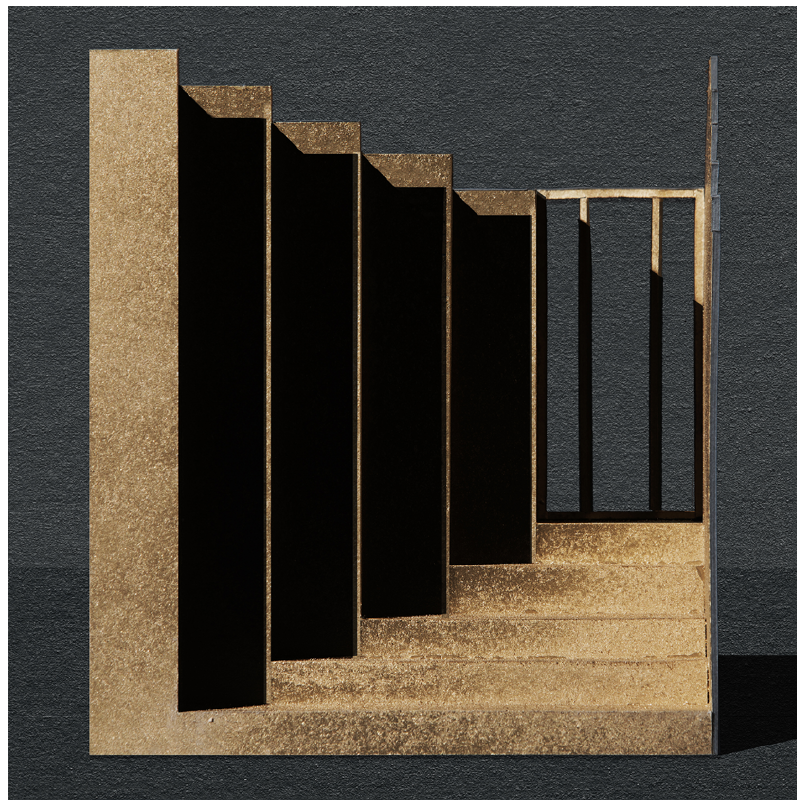
FIG. 6 Model of the double module as it is taken from the drawings by Gian Carlo Leoncilli Massi. related to the exhibition of “Venezia e lo spazio scenico” (1979), model in painted cardboard made by the author, scale 1:20. Photographer: Umberto Ferro, Laboratorio fotografico (Labfot)